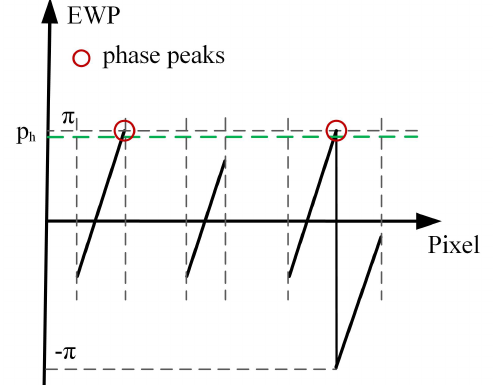
Figure 5. Wrapped phase without complete